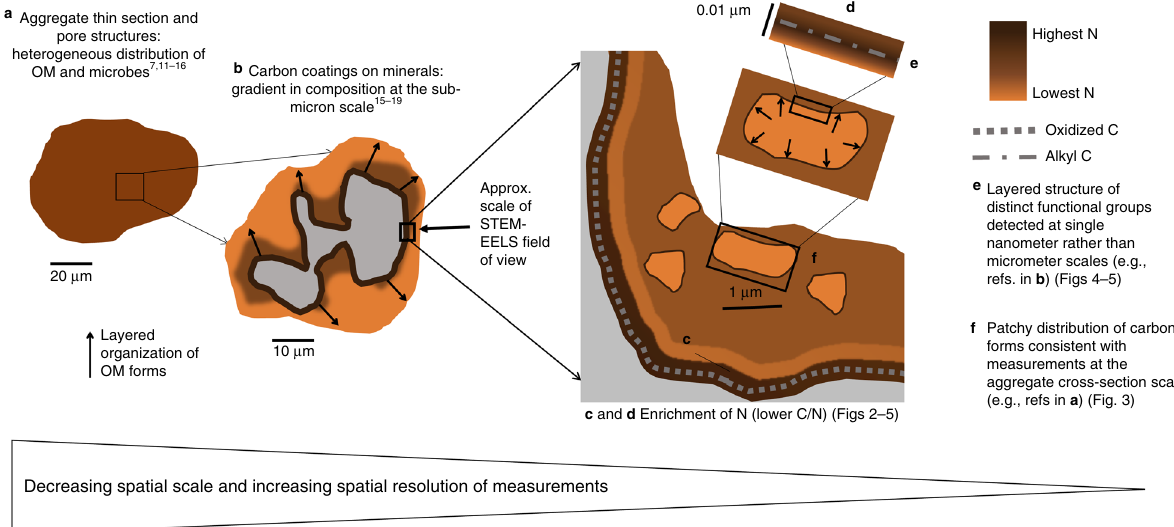
Fig. 1 Conceptual summary of organo – organic and organo – mineral interactions. Shifting conceptual view of the spatial architecture and composition of organo – mineral and organo – organic interactions. a At the scale of aggregate thin-sections, heterogeneous distribution of organic matter (OM) and microbial populations is well-known. b However, previous imaging and spectroscopic characterization of organo – mineral assemblages using a 10 – 50 μ m fi eld of view has shown organized OM layers of different composition. The concept of layered OM accumulation (i.e., the zonal model) has often been linked to nitrogen (N) enrichment at the mineral surface 20,21 . c – f The images and spectroscopic data presented in this study (conceptualized in c – f ) show an order of magnitude smaller spatial scale. c Enrichment of N was detected at an organo – mineral interface in a volcanic soil sample (Fig. 2). d – f Irregular organic structures and the organo – organic interface between them were also detected (in a separate volcanic soil sample) (Figs. 3 – 5). These observations directly reveal heterogeneous patches that contradict previous assumptions of ordered and unidirectional layering of OM forms, generating new insights into OM composition at mineral – organic and organo – organic interfaces. Note: scale bars are for illustrative purposes